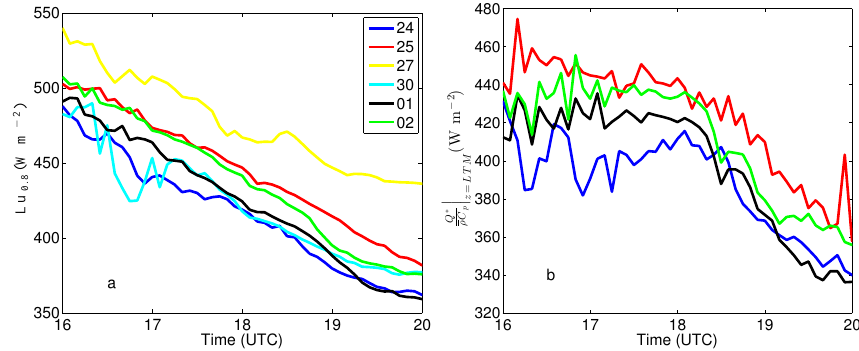
Figure 8. Temporal evolution of upwards longwave radiation (Lu) (a) measured at 0.8m on 24, 25, 27 and 30 June 2011 and 1 and 2 July 2011 and (b) estimated, by using Eq. (7), at LTM height on 24 and 25 June 2011 and 1 and 2 July 2011 using Eq. (7).